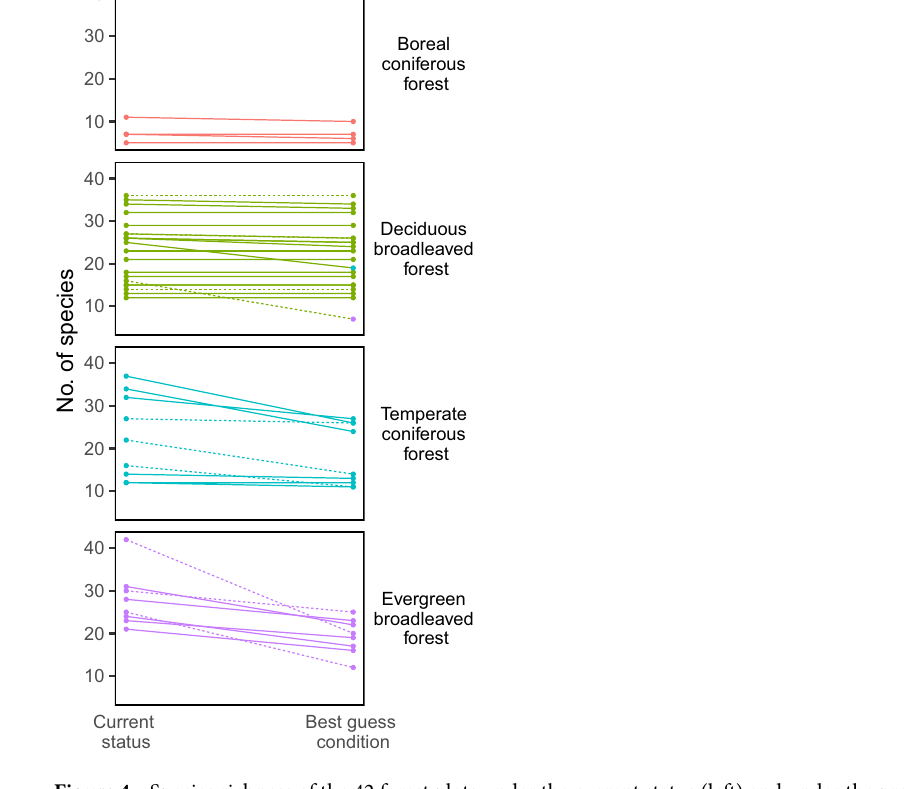
Figure 4. Species richness of the 42 forest plots under the current status (left) and under the projected trend mean of mean annual temperature (TM MAT ) in 2031–2050 (right) in the plots of each forest type. Solid lines, old-growth forests; dashed lines, secondary forests. Point color indicates forest type (see Fig. 3). Two plots of deciduous broadleaved forests shifted functional types at TM MAT (based on total basal area of surviving tree individuals), which is indicated by different point colors on the right